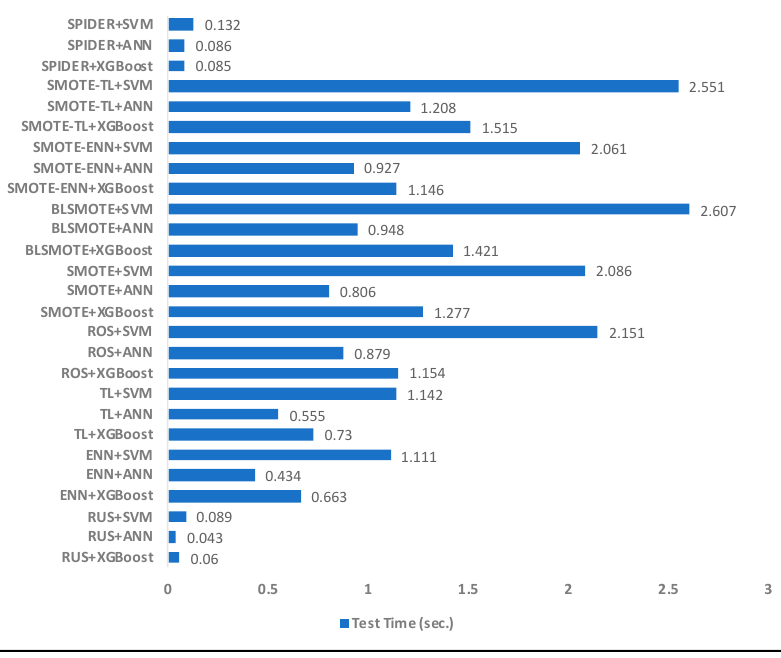
Figure 11. A testing time for all the fusion models.